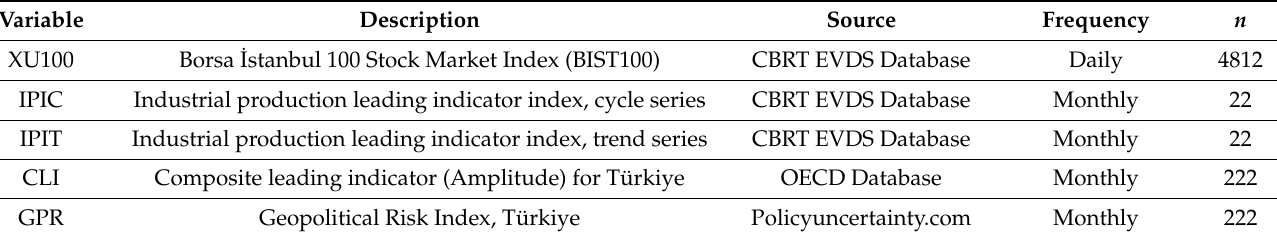
Table 1. Variable Description and Sources.